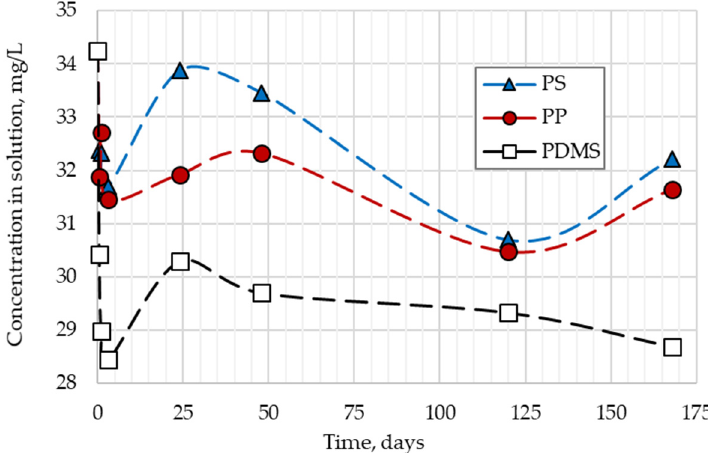
Figure 7. Sorption of IBU from water solution by three hydrophobic commercial membranes: PS, PP, and PDMS.